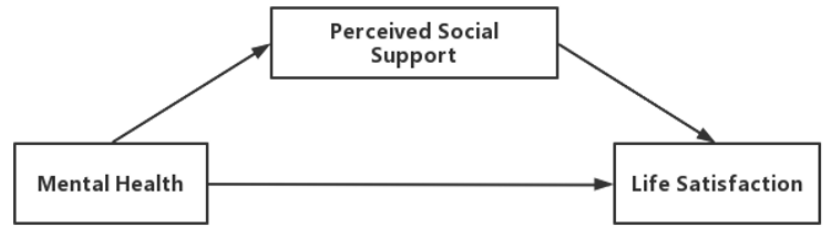
Figure 1. The conceptual framework of the mediating model.